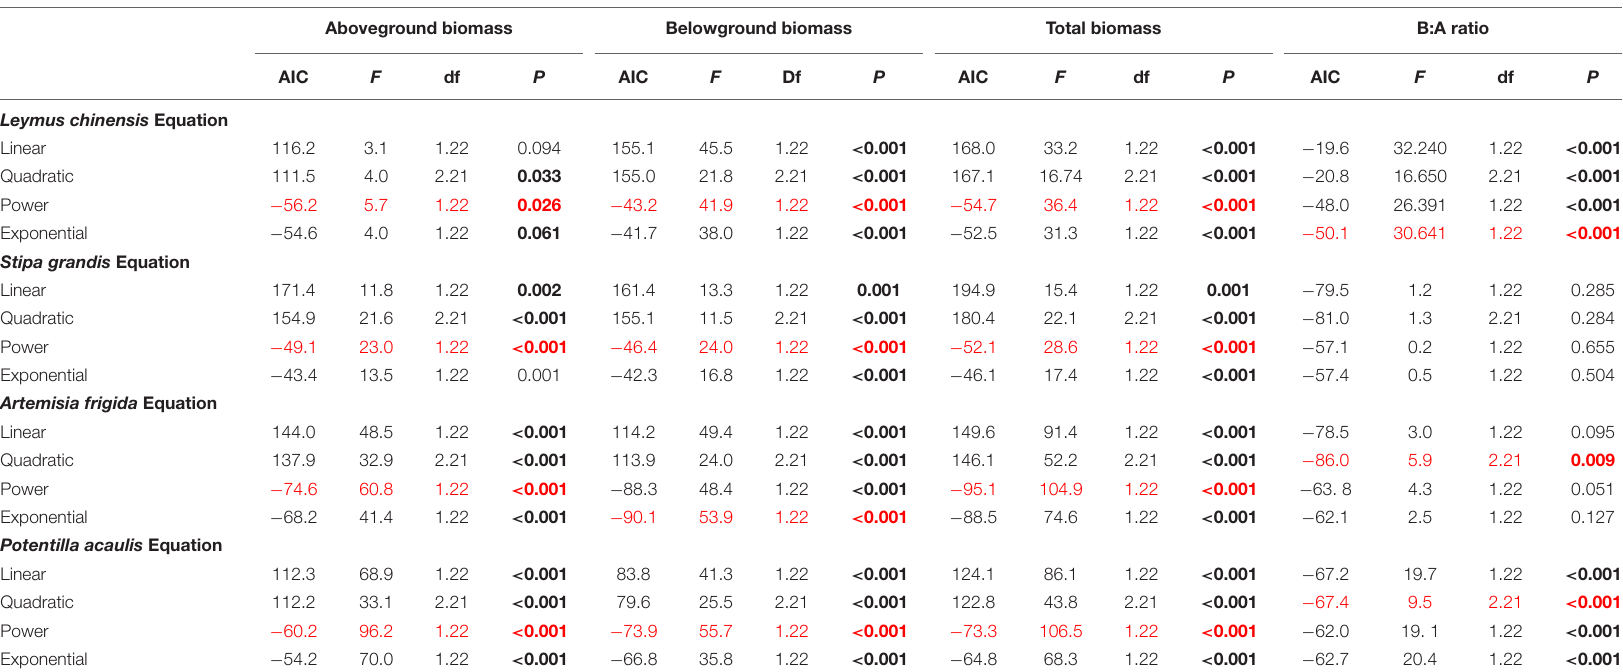
TABLE 2 | Results of the curve estimation of the relationships between precipitation amount and aboveground biomass, belowground biomass, total biomass, and B:A ratio (i.e., ratio of belowground biomass and aboveground biomass) of Leymus chinensis , Stipa grandis , Artemisia frigida , and Potentilla acaulis with linear, quadratic, power, and exponential equations, where AIC, F, df, and P value were showed. Aboveground biomass Belowground biomass Total